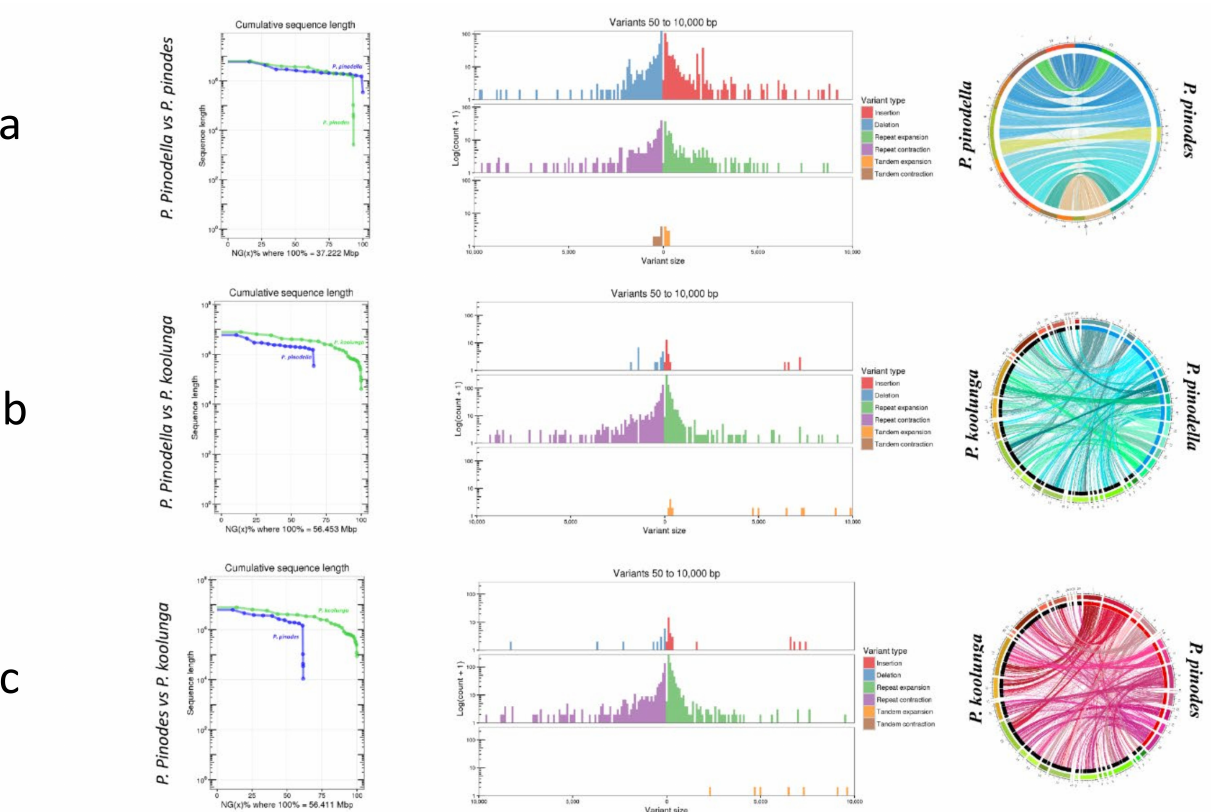
Figure 2. Structural variant (SV) analysis and Circos plots of AB species’ nuclear genomes between reference Isolate3Pp ( P. pinodes ), Isolate18Ppll ( P. pinodella ) and Isolate2Pk ( P. koolunga ). ( a ) SV analysis showing the higher occurrence of indels compared to repeats between the species and syntenic homology of P. pinodes (16 scaffolds, red) and P. pinodella (16 scaffolds, blue). ( b ) A comparison of P. pinodella (16 scaffolds, blue) and P. koolunga (29 scaffolds, black) reveals that repeat expansion and contraction are the most prevalent SV. Less homology is observed in ( b ) compared to ( a ). ( c ) Similarly to ( b ), a comparison of P. pinodes (16 scaffolds, red) and P. koolunga (29 scaffolds, black) shows that the most prevalent SV is repeat expansion and contraction, and there is less homology between the species compared to ( a